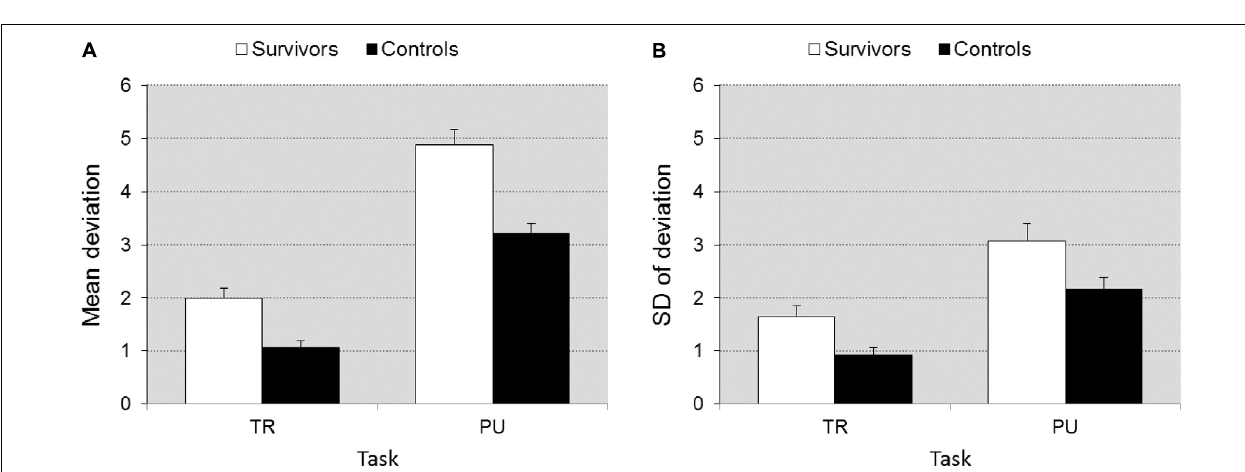
FIGURE 2 | Accuracy ± SEM (A) and fluctuation in accuracy ± SEM (B) as a function of task (TR vs. PU). Illustrates the significant group × task interaction. The differences between groups is larger on task PU (higher executive function demands) than on TR (lower EF